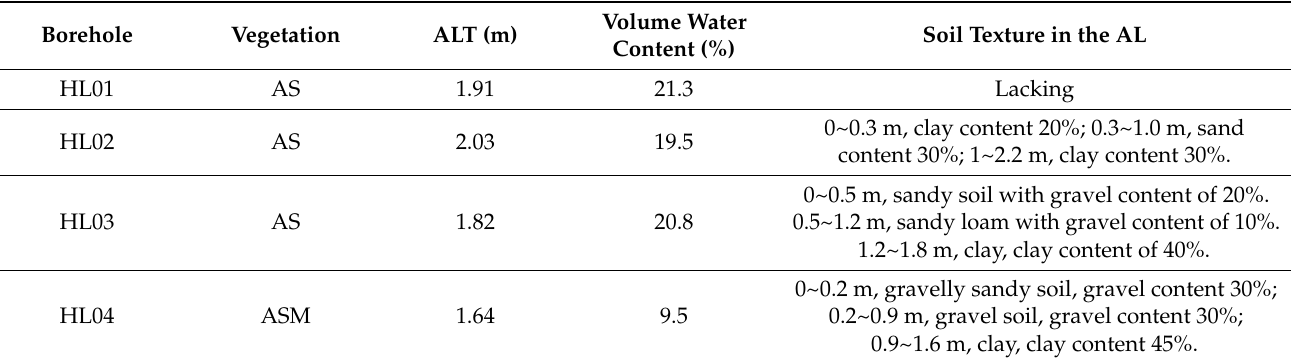
Table 1. Basic information on field observation data.